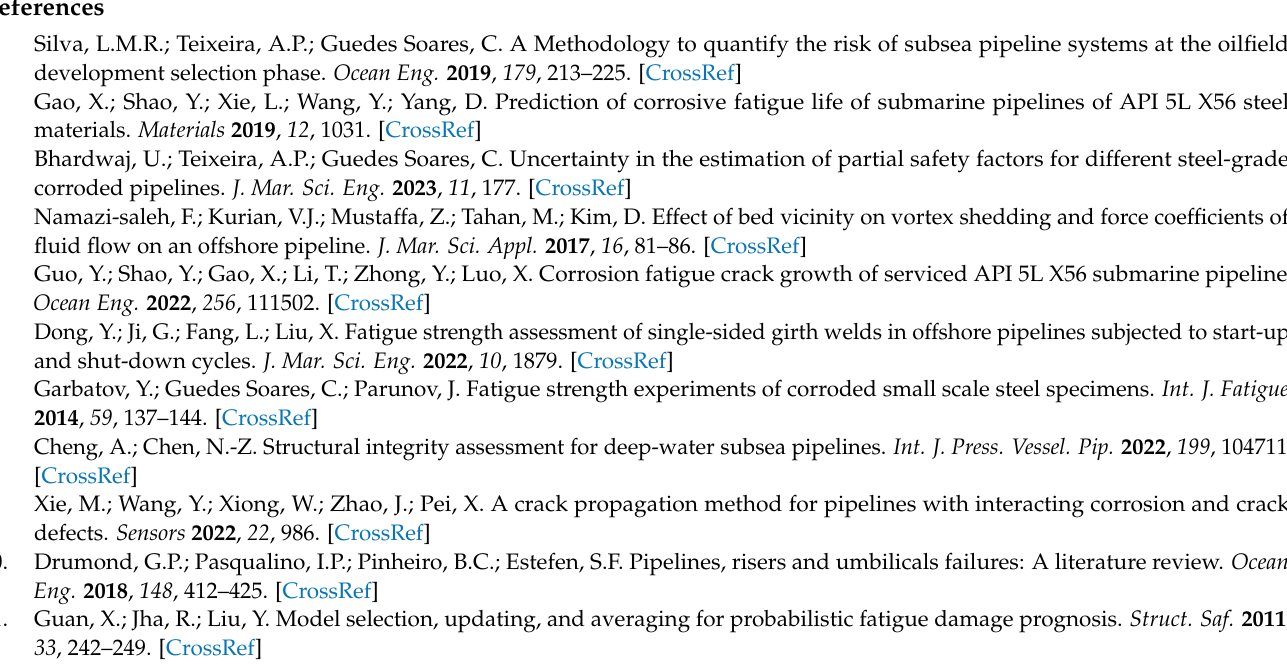
Figure A2. The mean values of fatigue crack growth for normal and uniform prior distribution.